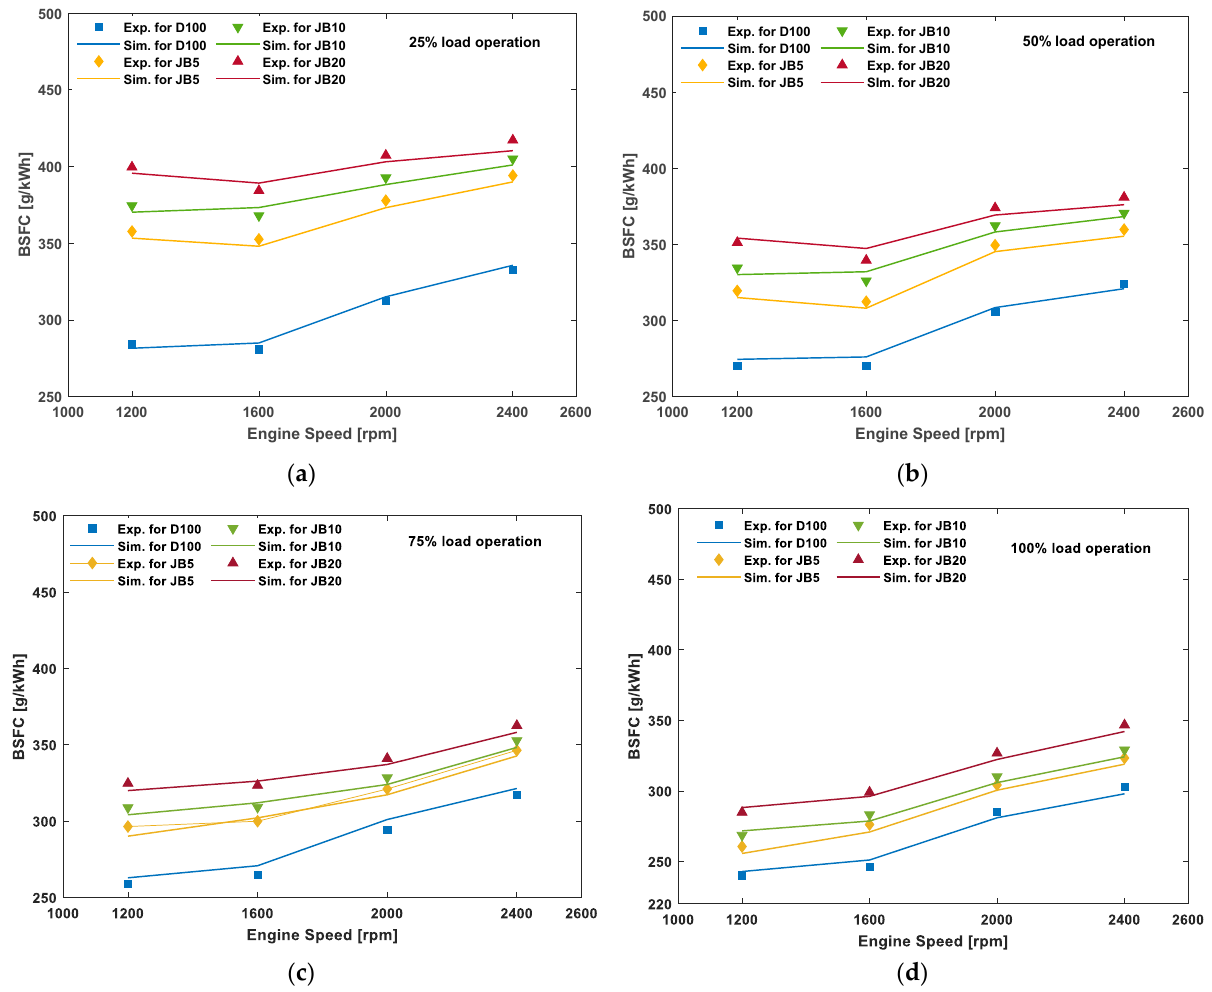
Figure 6. Comparison between simulation and experimental results of BSFC for diesel and JB blends at ( a ) 25%, ( b ) 50%, ( c ) 75% and ( d ) 100% loading conditions.